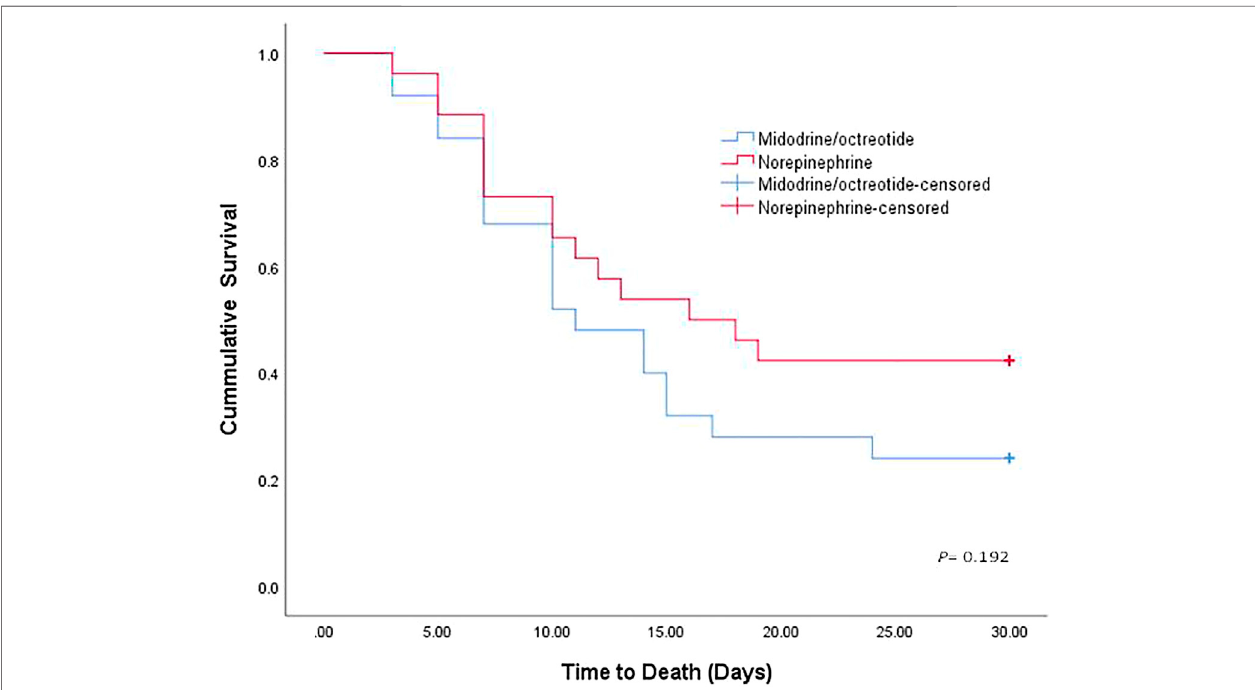
FIGURE 2 | Kaplan – Meier curve showing the cumulative probability of overall survival of patients treated with norepinephrine and midodrine plus octreotide.